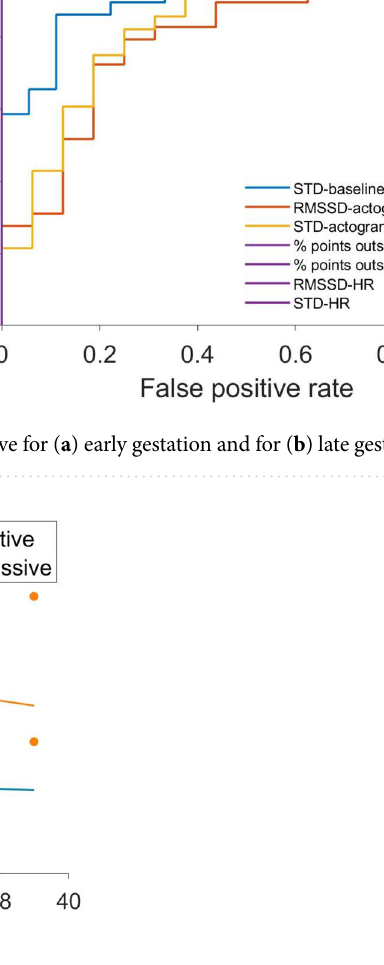
Figure 5. Decrease over gestational age of RMSSD-HR (bpm) in active but not passive